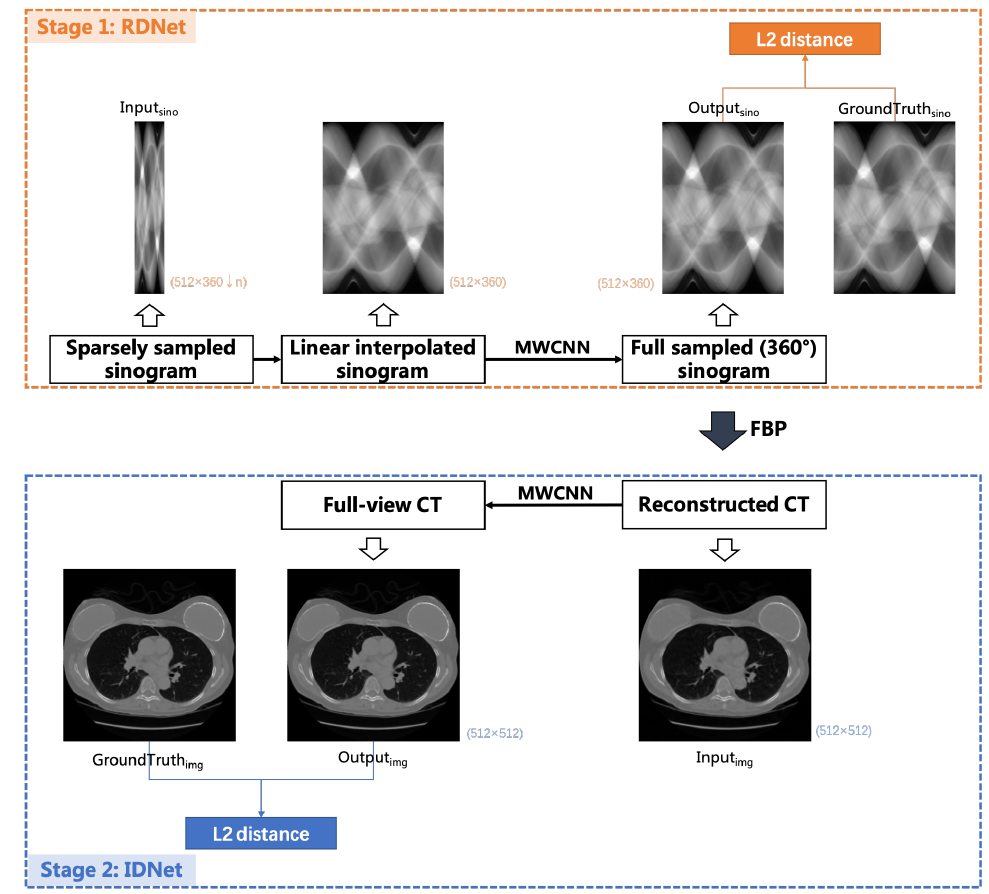
Figure 4. The hybrid domain reconstruction model for sparse-view